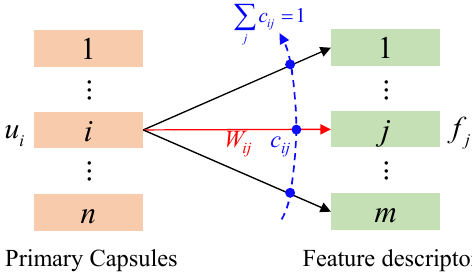
Figure 8. Illustration of the dynamic routing